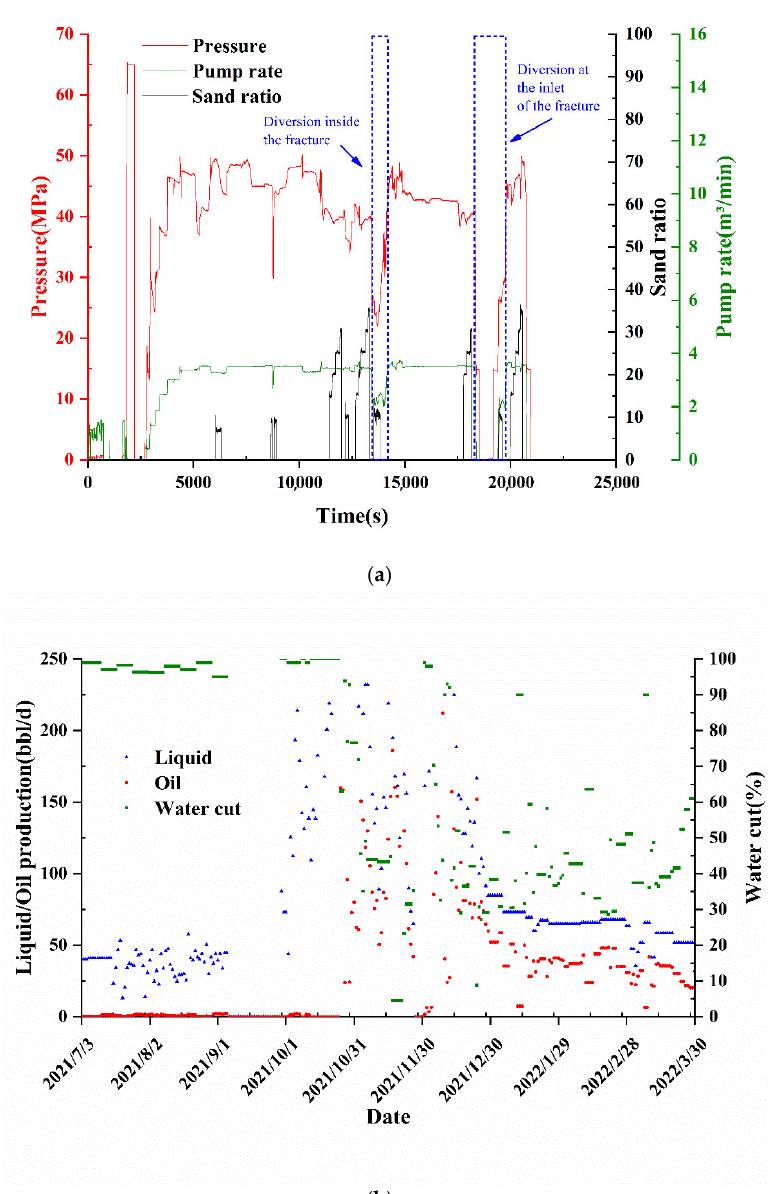
Figure 9. The treating curves and production data of well b20104. ( a ) The treating curves during the fracturing operation; ( b ) The production data.